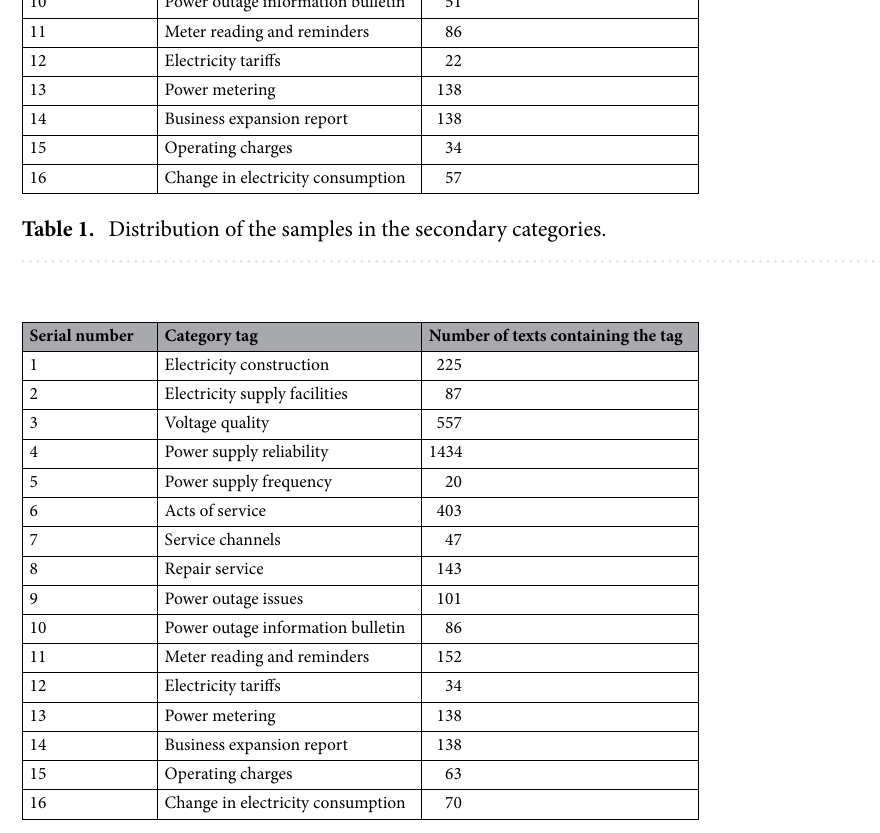
Table 2. Distribution of the complaints after text